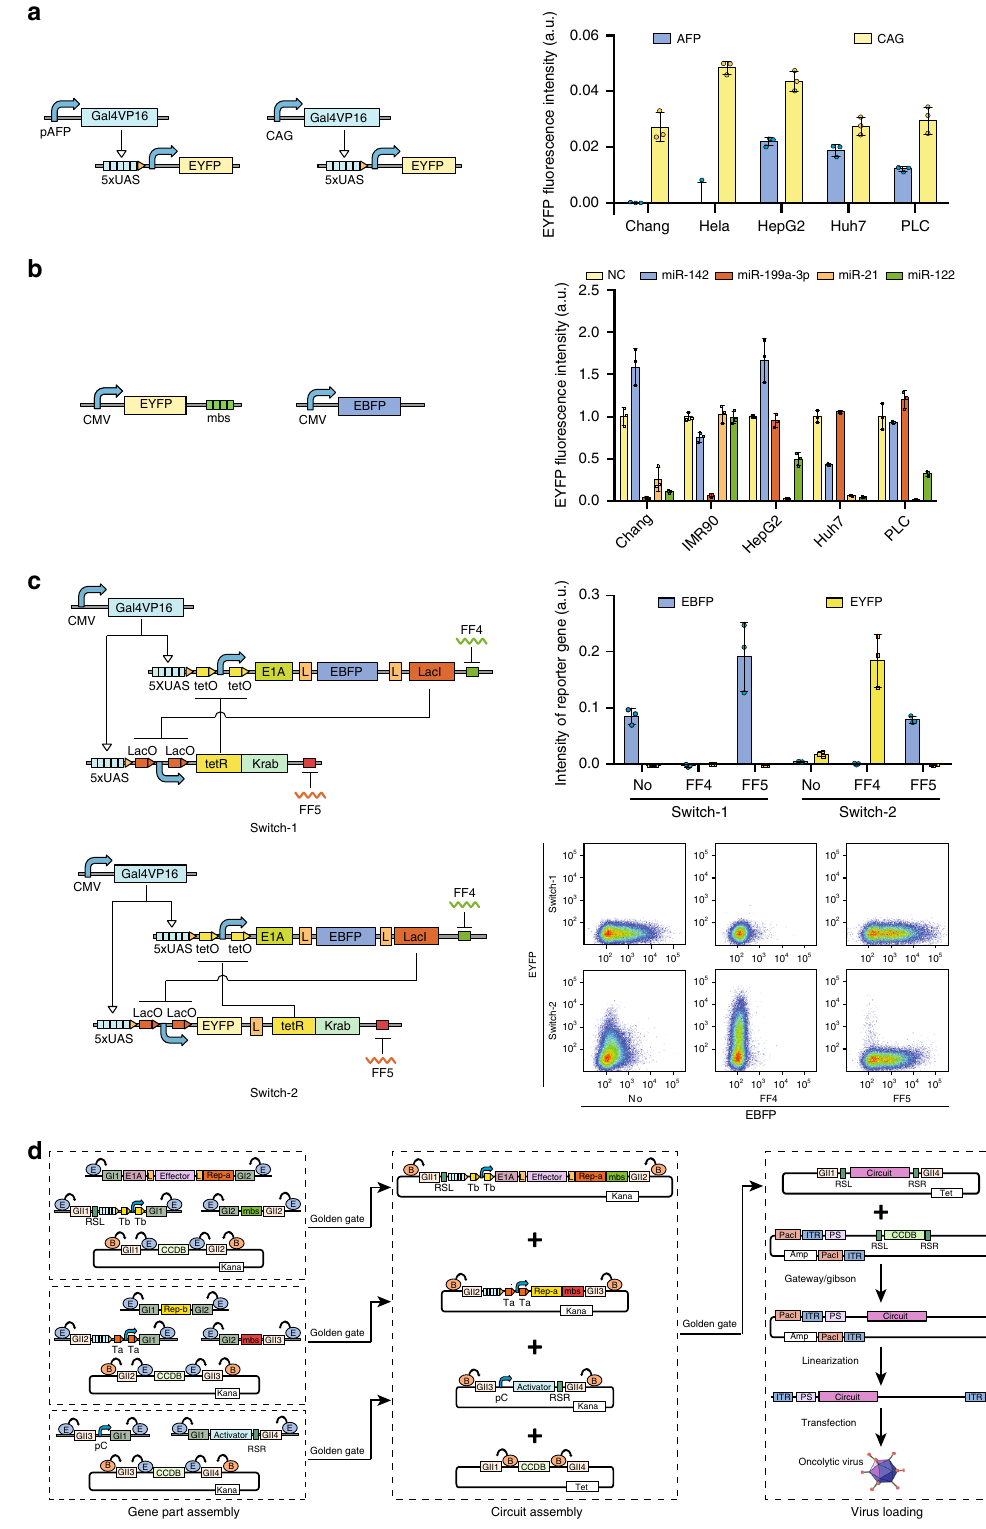
method 38 . In the fi rst round of Golden Gate reaction, different genetic elements including the promoter, coding regions and microRNA binding sites that are selected for targeting speci fi c cancer cells were assembled into three gene parts (Fig.